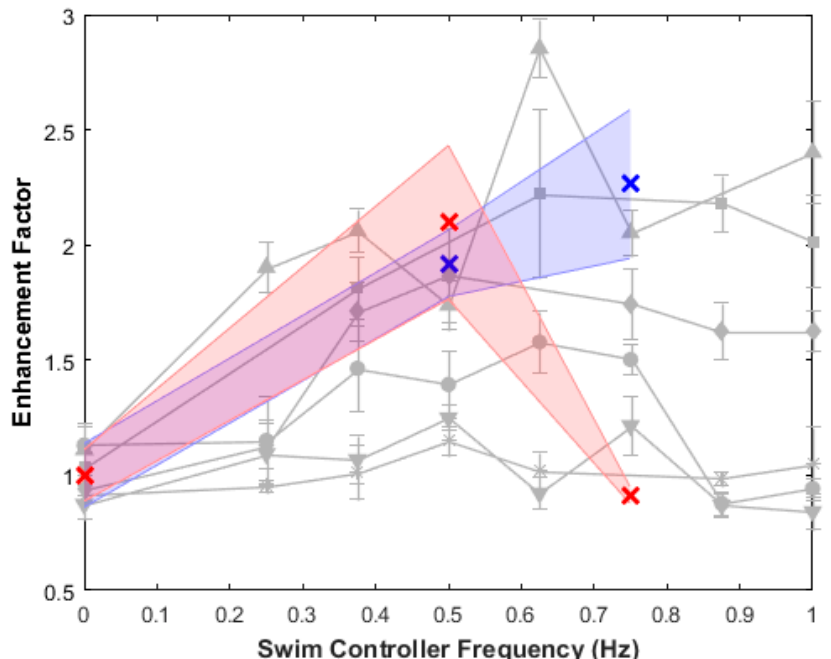
Figure 7. Enhancement factors measured in field work compared to prior work in the lab. The enhancement factor is defined as the swimming speed of each trial divided by the control case at 0 Hz, in which the swim controller is embedded but inactive. An experimentally driven frequency trial for each animal ( n = 2, shown in blue or red) has been normalized to its own control trial. Prior laboratory work from similar vertical swimming experiments is shown in gray as a comparison, with symbol shape representing each individual animal ( n = 6) [32]. Variability in the enhancement factor is influenced by the animals’ baseline swimming frequency, in the absence of stimulation.